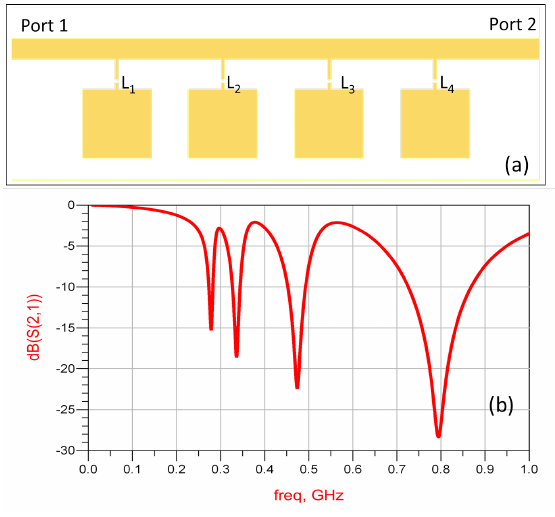
Figure 8. ( a ) The simulated microstrip structure in ADS; ( b ) simulated transmission